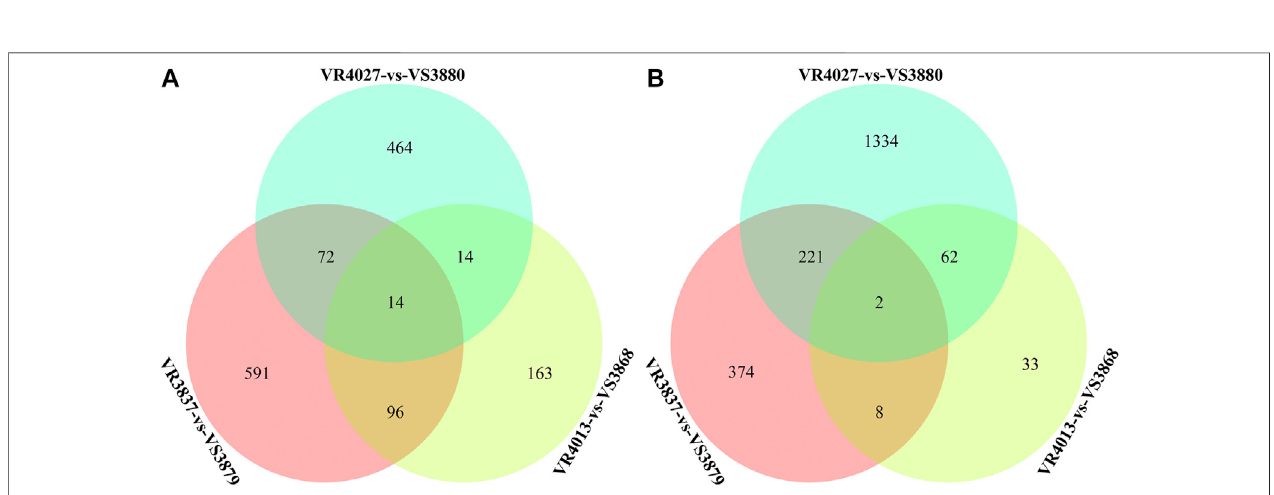
FIGURE 4 | Venn diagrams for three pairwise comparisons of resistant and susceptible families. (A) Differentially expressed genes (DEGs) with high expression in susceptible families. (B) DEGs with high expression in resistant families.